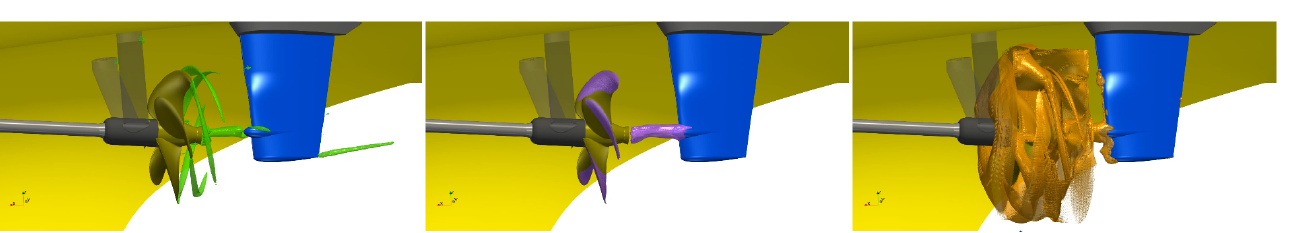
Figure 19. Instantaneous pressure 𝑝 in [Pa] at arbitrary converged timestep on midplane through the propeller and corresponding Lighthill stress tensor magnitude |𝑇 (cid:3036)(cid:3037) | in [Kg/ms (cid:2870) ]. While the pressure information in Figure 19a itself is not useful to quantify acoustic emissions, it is indicative of locations of high-pressure gradients, which are attributed to noise emissions. The Lighthill stresses in Figure 19b on the other hand indicate similar regions as the isosurfaces, with strong fluctuations at the tip vortex and the hub vortex, on the propeller blade suction sides, upstream of the rudder around 𝑟/𝑅 = 0.7 , and be- hind the rudder at the 12 o’clock position, and in addition below the rudder similar to the pressure pulses in Figure 18. Thus, it seems that this representation combines the high- lighted regions from all previous methods and thus proves itself a valuable tool to indicate noise sources. The Lighthill stress tensor is evaluated from the symmetric fluid compressive stress tensor from Equation (13), shown in Figure 20 for reference, which in turn is obtained from the symmetric perturbation stress tensor from Equation (12) in Figure 21. In the fig- ures, the tensor components are sorted according to their location in a 3𝑥3 matrix, and symmetric tensors are only shown for the upper right side. It has to be noted that the off- diagonal elements experience small value ranges of [−1; 1] compared to the main diago- nal with only positive values of [0; 5 × 10 (cid:2872) ] , meaning that the colormaps are selected to yield the best visualization and sacrifice comparability between tensor elements.